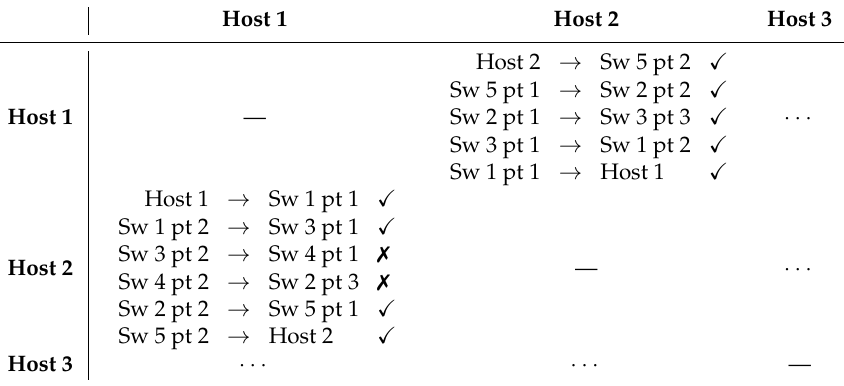
Figure 9. Information stored by the Path matrix component when testing the network shown in Figure 4. Columns identify the sources of the traffic, while rows identify the destinations. Switches are abbreviated to Sw and ports to pt